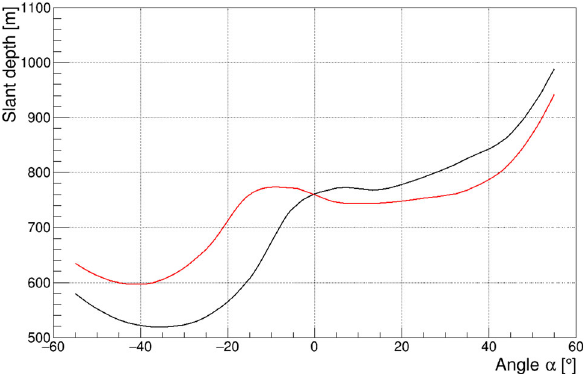
Fig. 2 Slant depth as a function of the projection angle along the plane defined by the railroad tunnel. The black line corresponds to the view fromLAB2400.Theredline,fromLAB2500.Thepositiveanglesarein the SSE direction(towards France). The negative, intheNNW direction (towards Spain)